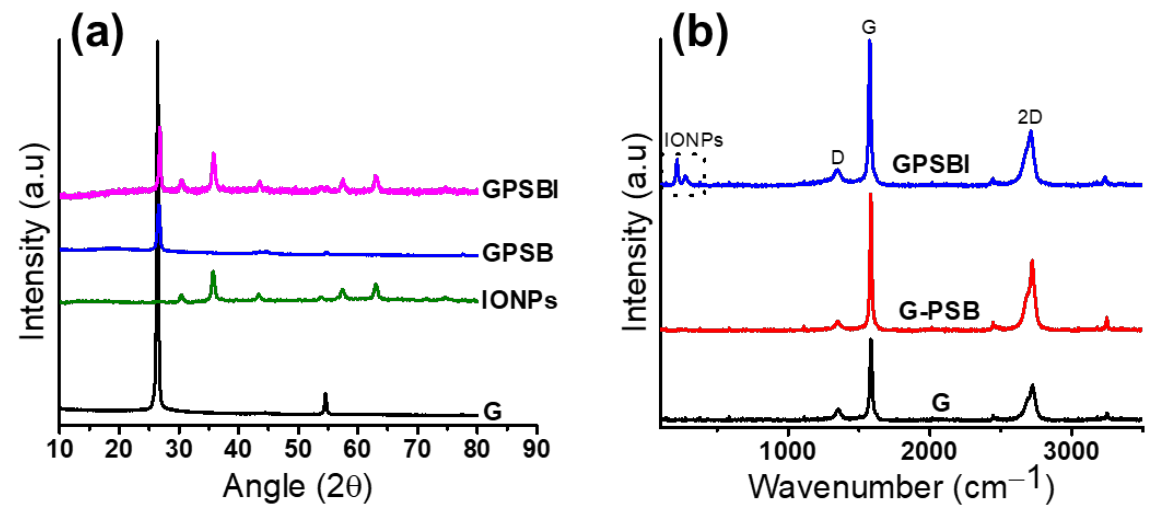
Figure 1. ( a ) XRD patterns corresponding to G, IONPs, GPSB, and GPSBI. ( b ) Raman spectra of G, GPSB, and GPSBI.